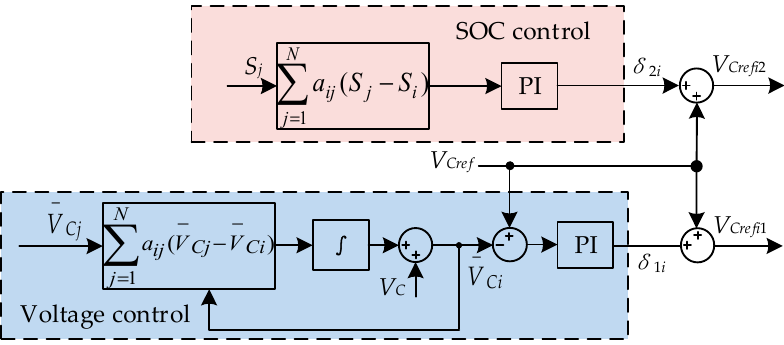
Figure 6. The proposed secondary control of the DCES.